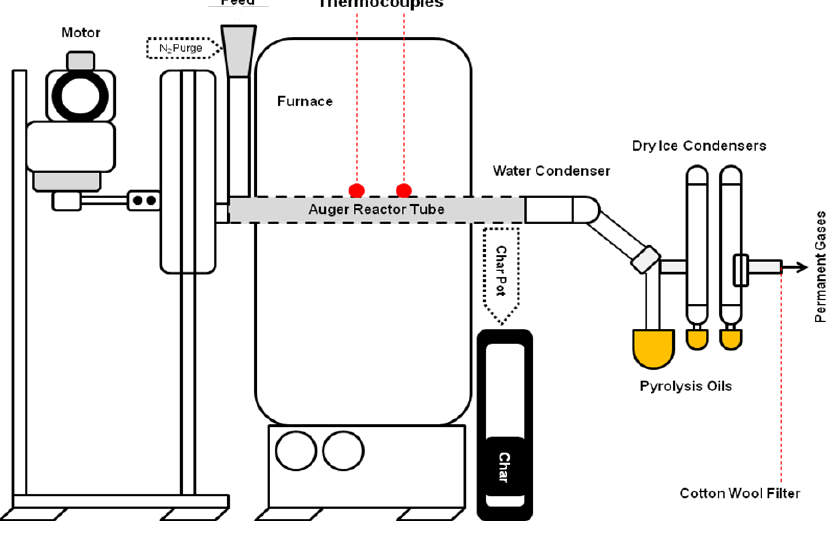
Figure 1. Schematic diagram showing the various parts of the auger paralysis reactor system used in this